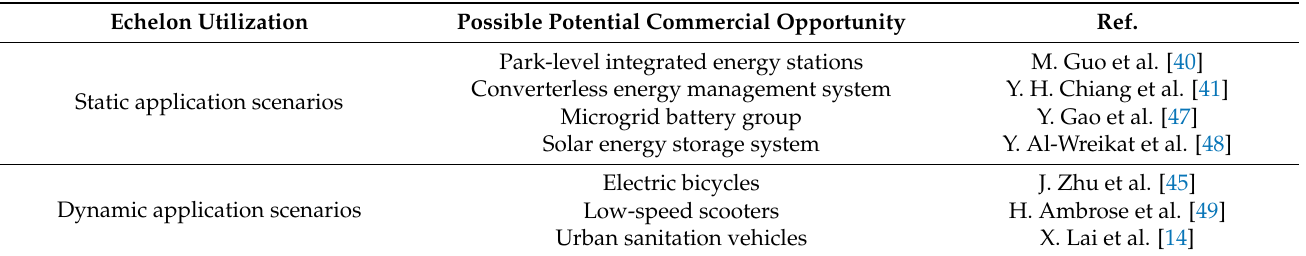
Table 5. The application scenario of echelon